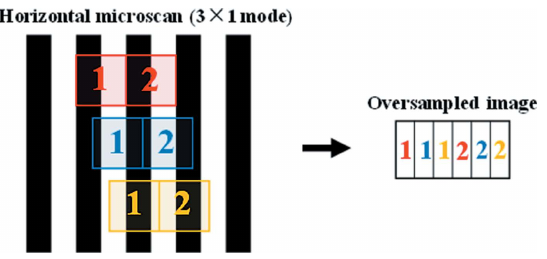
Figure 7 Spectrum of the pink beam converted from the white beam of the BSRF 3W1 beamline using two filters (500 m m-thick Al and 200 m m-thick Ag)